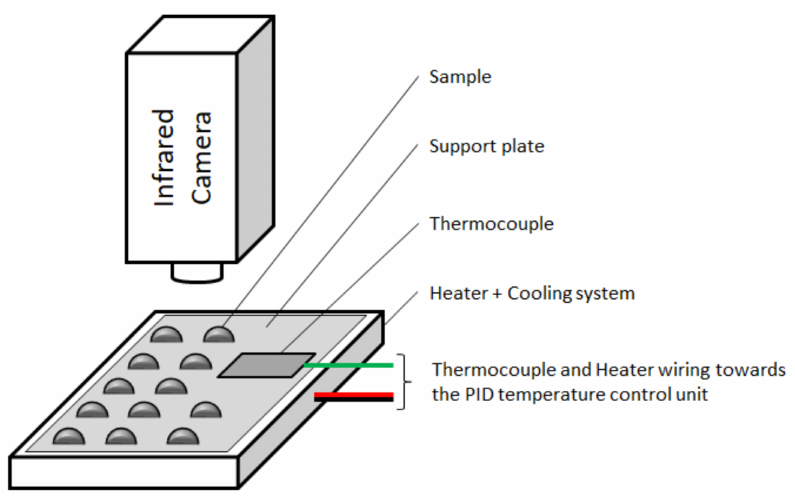
Figure 1. Scheme of the experimental